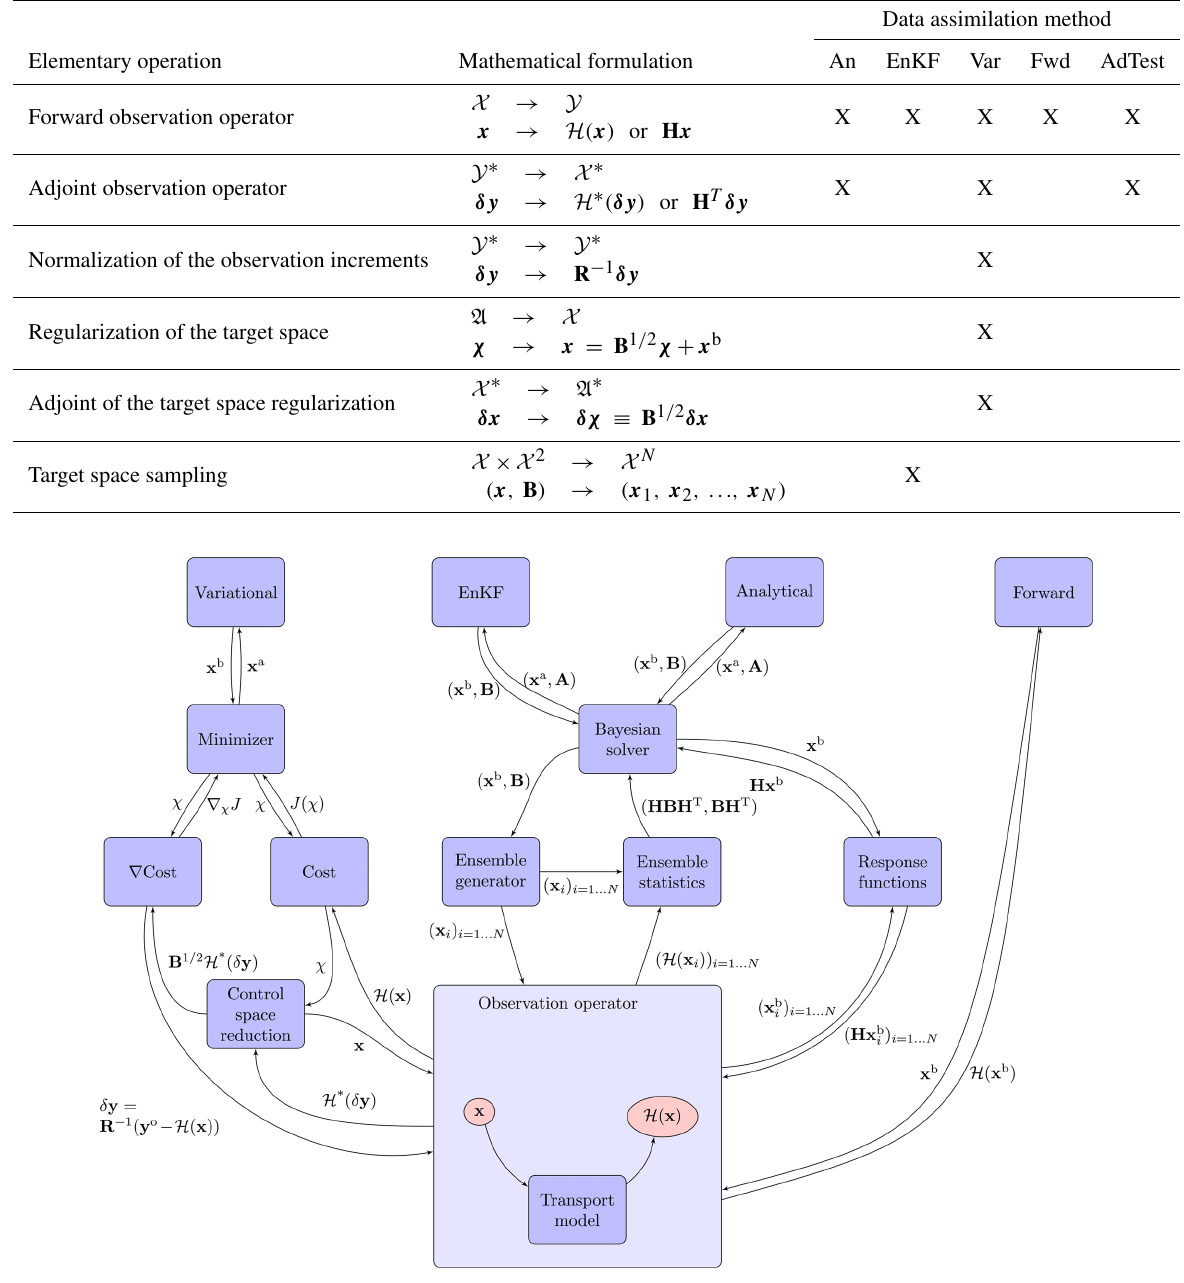
Figure 1. Call structure of the CIF.